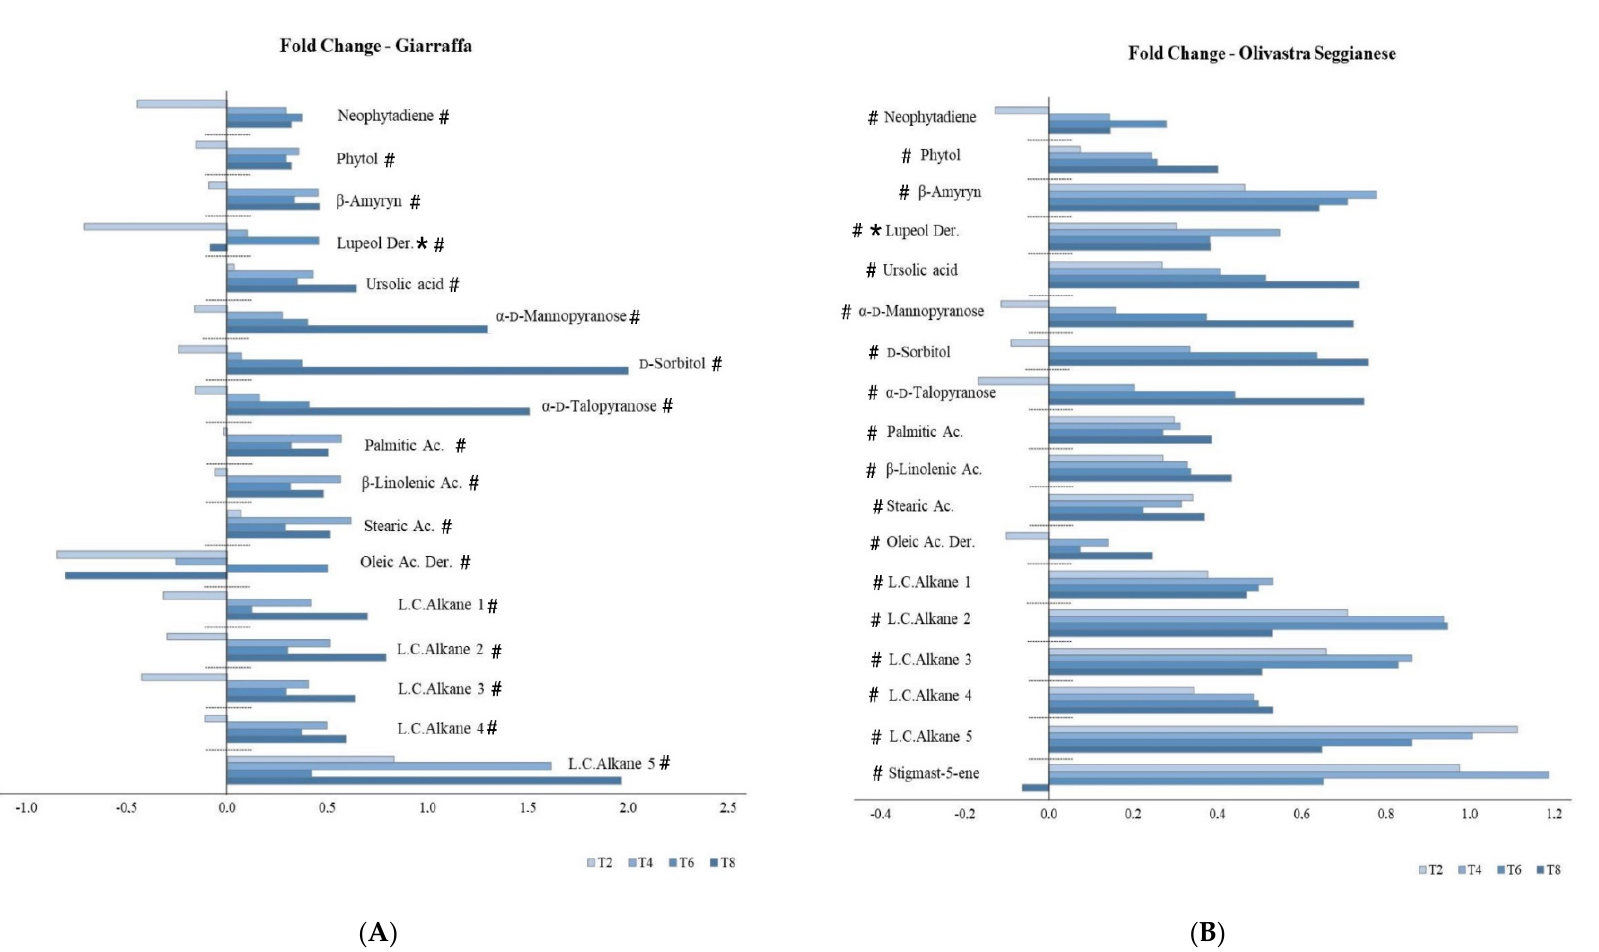
Figure 2. Fold changes (log 2 (UV-B/control)) in lipophilic metabolites of the Giarraffa ( A ) and Olivastra Seggianese ( B ) varieties after UV-B treatment sampled at the 2nd (T2), 4th (T4), 6th (T6), and 8th (T8) week after the onset of stress. ANOVA showed that most of chemical components were significantly affected by the main factors and their interactions. An asterisk (*) indicates a significant interaction between treatment vs. variety; a hashtag (#) indicates a significant interaction between treatment vs. sampling time.